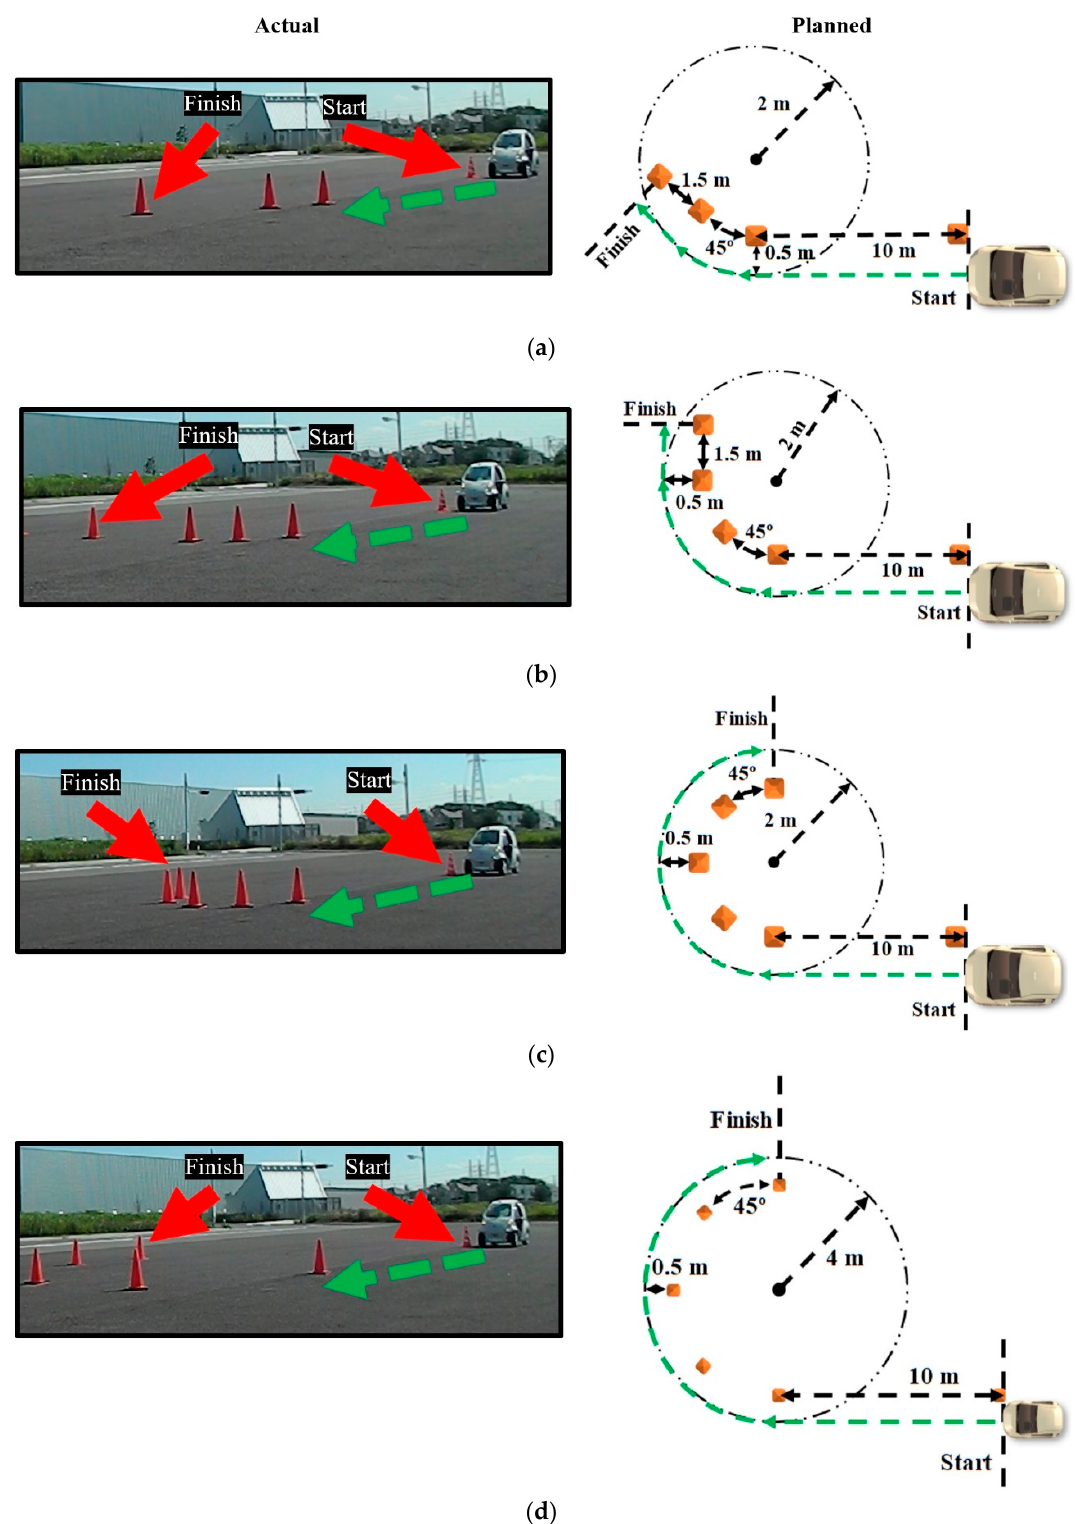
Figure 6. All drivers tested path-following accuracy of steering wheel and Myo armband by performing: ( a ) 45° turn; ( b ) 90° turn; ( c ) narrow U-turn; and ( d ) wide U-turn. Previous testing demonstrated that the Myo armband had a maximum mean gesture classification percent error of 11.95 SD 9.00. There was no significant difference between this error